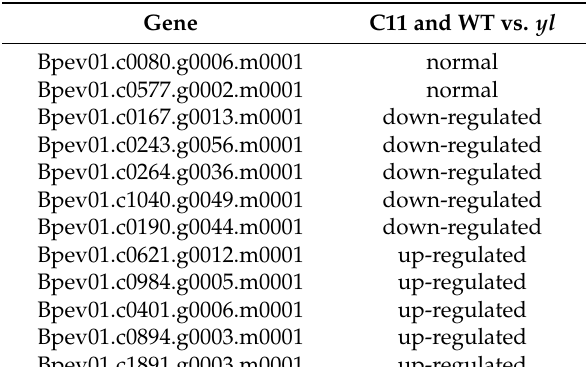
Table 3. The genes used for qRT-PCR.